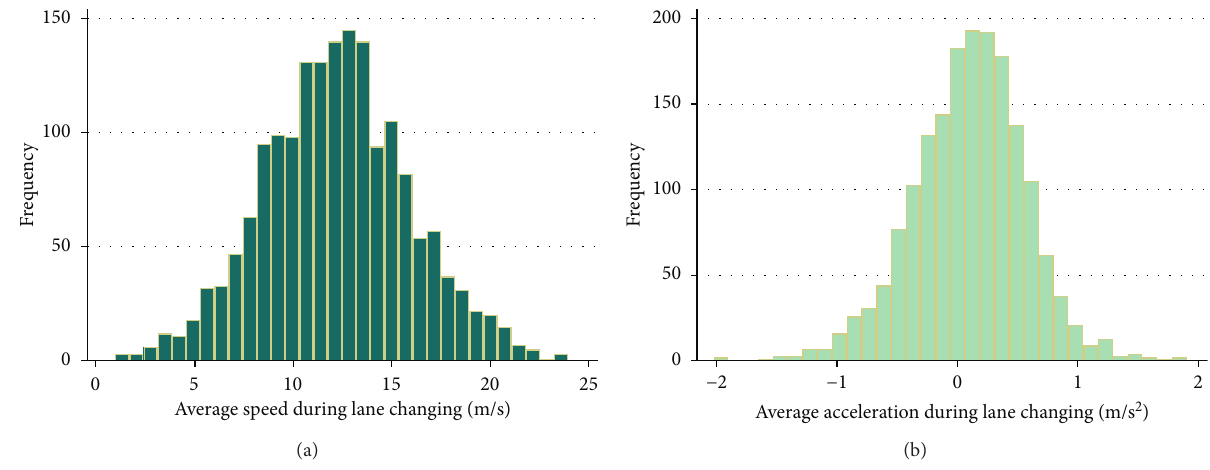
Figure 6: Average speed (a) and acceleration (b) during lane changing.